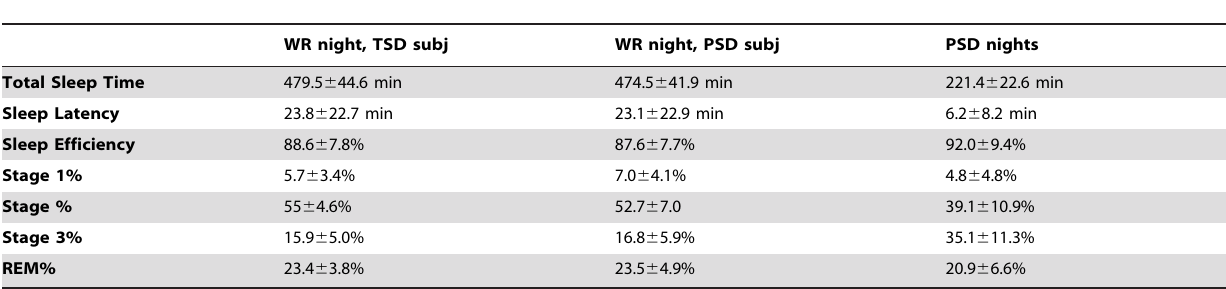
Table 2. Sleep Data from Nights in the